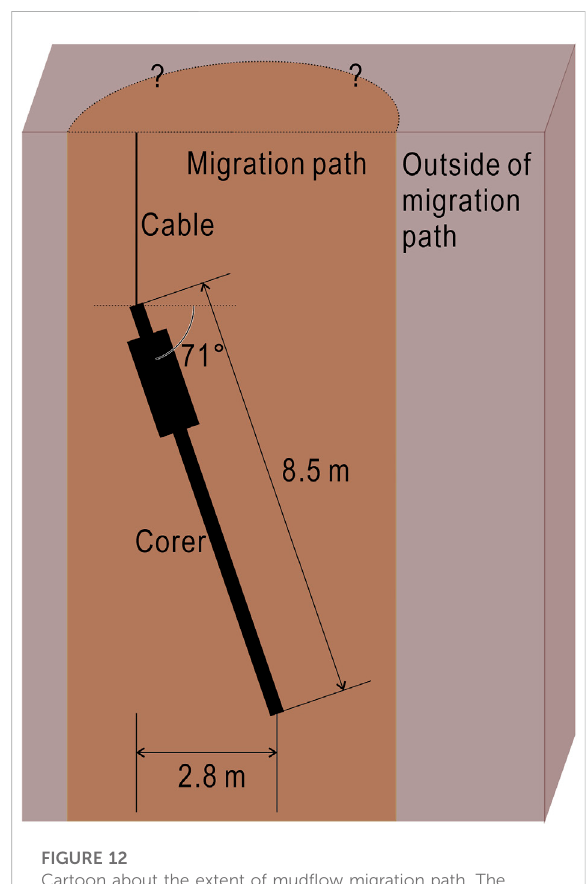
FIGURE 12 Cartoon about the extent of mud fl ow migration path. The most inclined angle of the probe was 71 ° during overpenetration. The total length of the probe is ~8.5